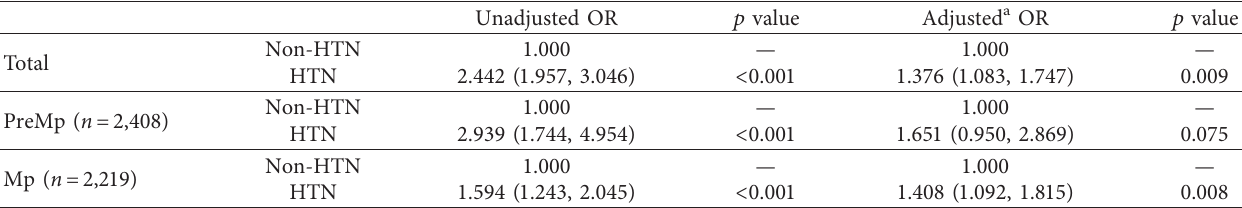
Table 4: Association between hypertension and osteoarthritis among total, premenopause, and menopause groups from logistic regression